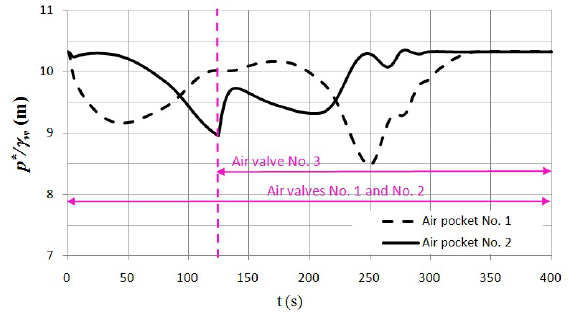
Figure 5. Evolution during the hydraulic event of the absolute pressure of the air